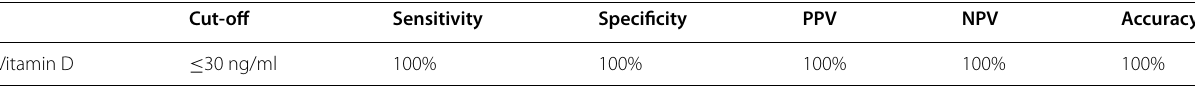
Table 5 Diagnostic performance of vitamin D in detecting COVID-19 patients